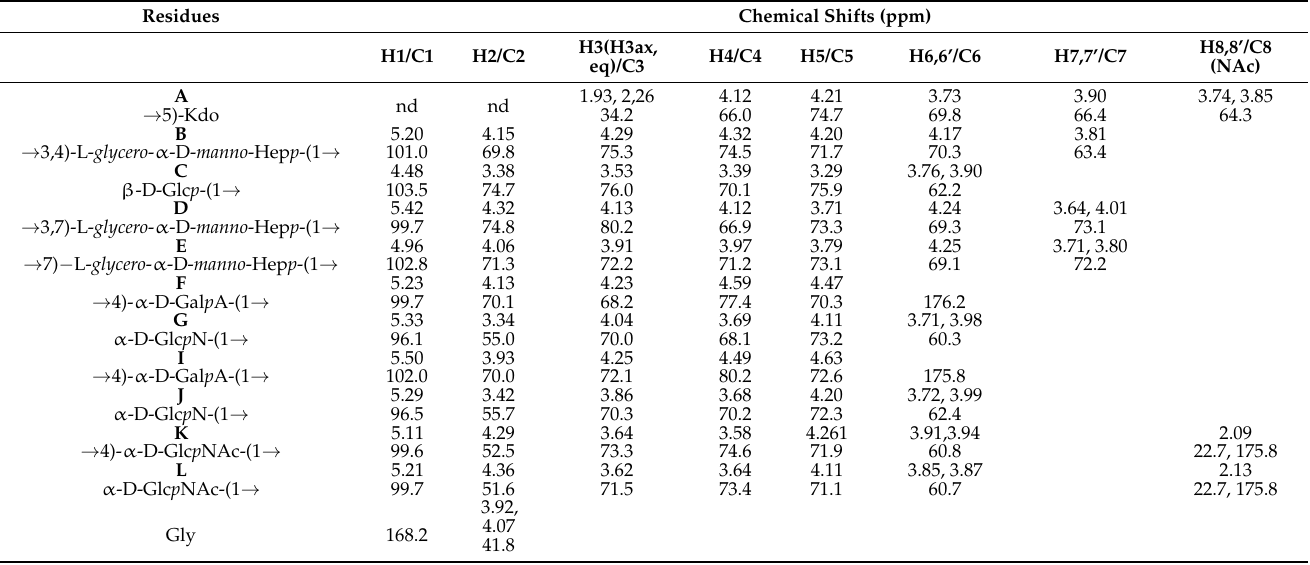
Table 2. Chemical shifts of the E. hoshinae DSMZ 13771 T core oligosaccharide